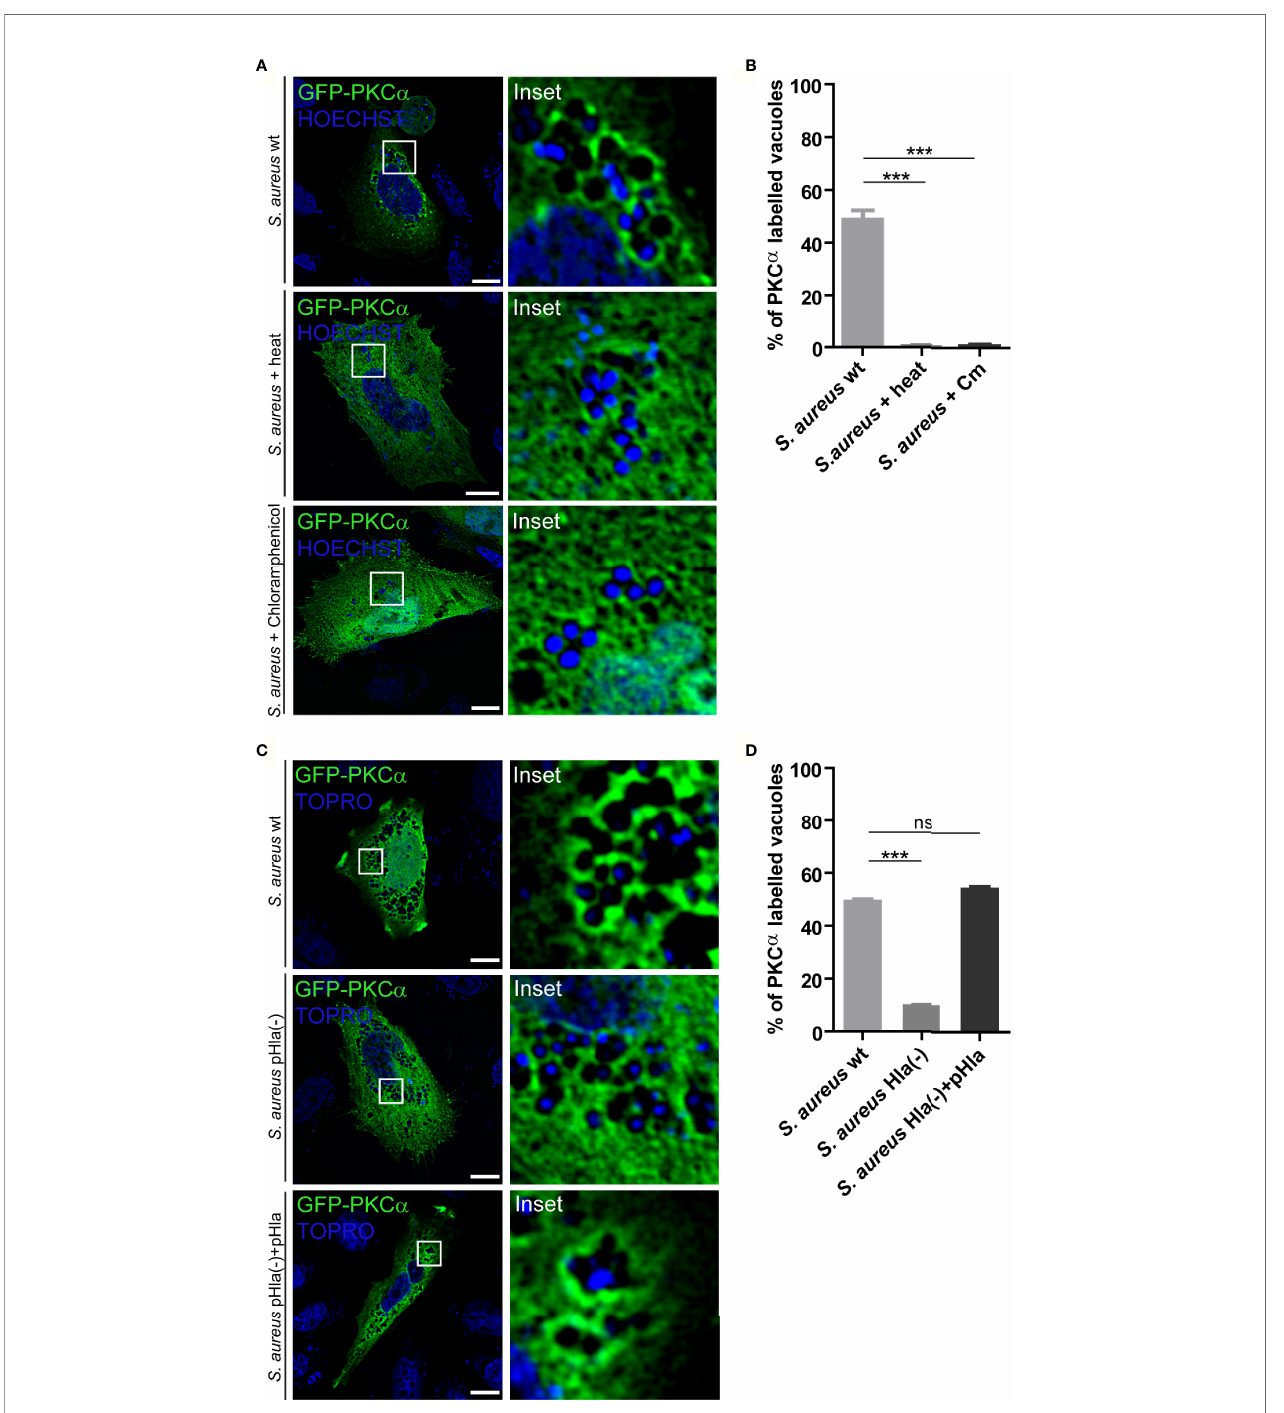
FIGURE 4 | PKC a recruitment to S. aureus phagosomes depends on a -hemolysin. (A) Confocal microscopy images of CHO cells overexpressing GFP-PKC a , and then infected for 4 hours with S. aureus wt, S. aureus wt killed by heat or S. aureus wt treated with chloramphenicol. Bacteria were labelled with Hoechst (shown in blue). Bar: 10 m m. Images are representative of four independent experiments. (B) Quanti fi cation of S. aureus vacuoles labelled with GFP-PKC a in cells infected with S. aureus wt, S. aureus wt heat killed or S. aureus wt inactivated by chloramphenicol treatment. Data are the mean ± SEM of four independent experiments. ***p ≤ 0.0001. (C) Confocal microscopy images of CHO cells overexpressing GFP-PKC a , and then infected with S. aureus wt, S. aureus Hla ( – ), mutant de fi cient of a -hemolysin or S. aureus Hla ( – )+pHla, mutant complemented with the a -hemolysin for 4 hours. Bacteria were labelled with Topro (shown in blue). Images are representative of fi ve independent experiments. Bar: 10 m m. (D) Quanti fi cation of S. aureus vacuoles labelled with GFP-PKC a in cells infected with S. aureus wt, S. aureus Hla ( – ) or S. aureus Hla ( – )+pHla. Data are the mean ± SEM of fi ve independent experiments. ***p ≤ 0.0001; ns, non signi fi